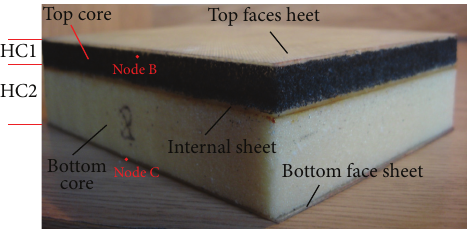
Figure 3: The multilayer sandwich specimen with two different core types in top and bottom